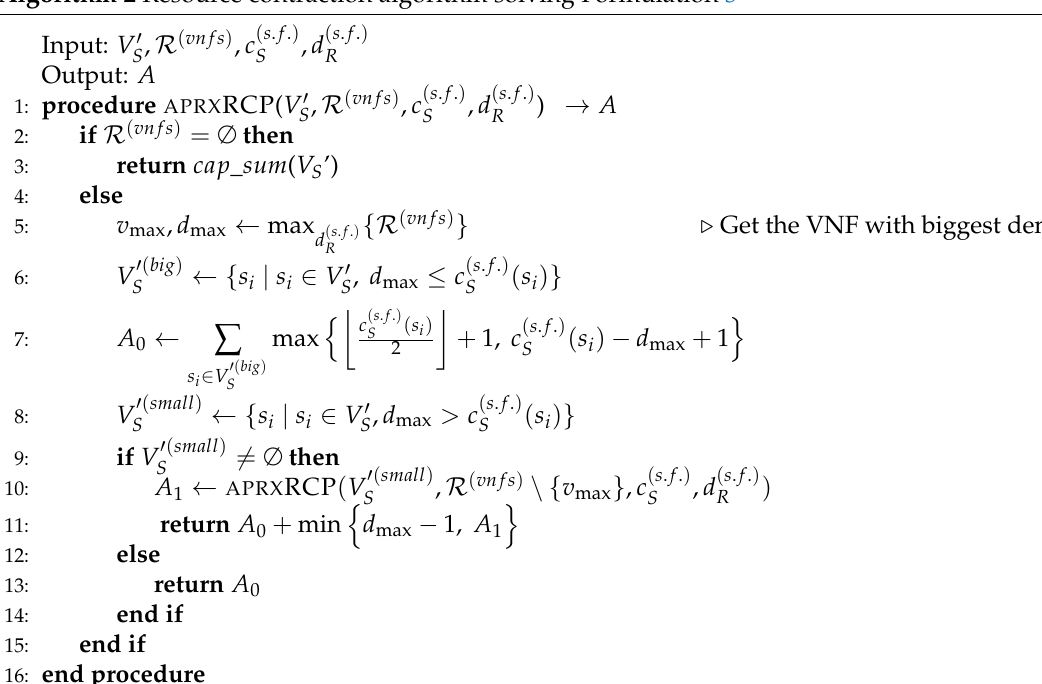
Algorithm 2 Resource contraction algorithm solving Formulation